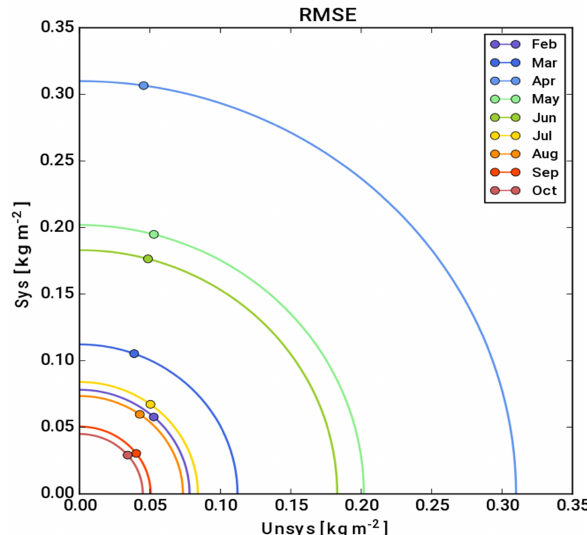
Figure 12. Root mean square error divided into systematic and un- systematic parts for all months. The radii of the circles correspond to the monthly averaged RMSE values. Blue colours represent the cold and dry period; warm colours represent the warm and humid period.